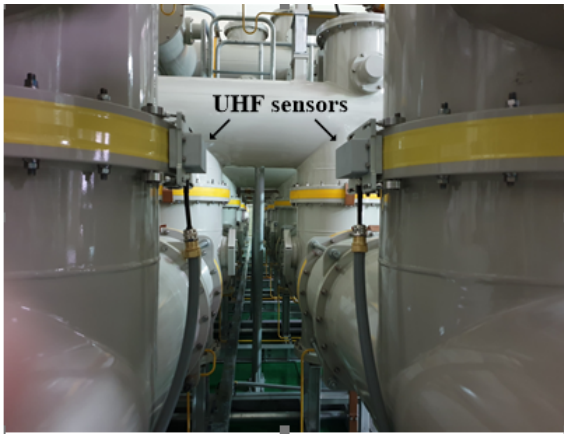
Figure 5. On-site noise measurements.